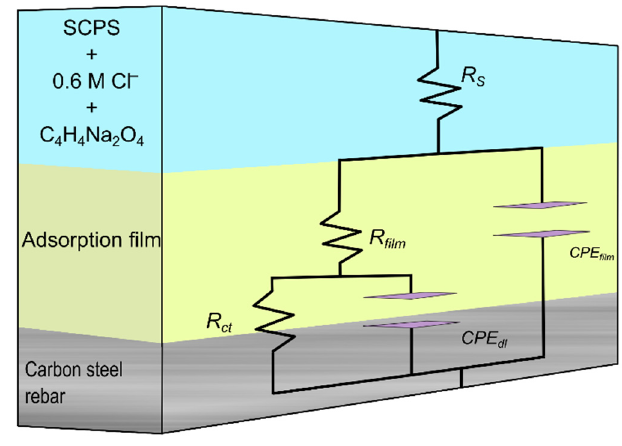
Figure 5. Electrical equivalent circuit (EEC) used to fit EIS data.